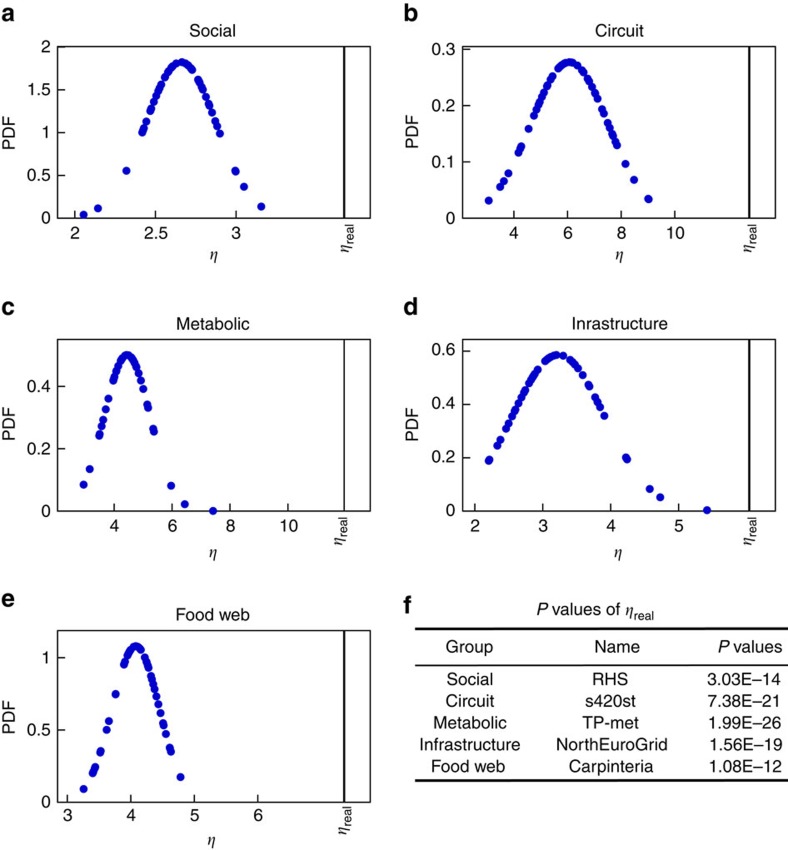
DPR of real networks.Probability density functions (PDF) of the distribution of η for a selection of real networks that have undergone DPR and nd=0.45. (a) RHS59 from social. (b) s420st (ref. 53) from circuit. (c) TP-met54 from metabolic. (d) North Euro Grid60 from infrastructure. (e) Carpinteria55 from Food Web. (f) Each of the corresponding P values are listed in the table. The vertical lines mark the value of ηreal, which corresponds to the original network.